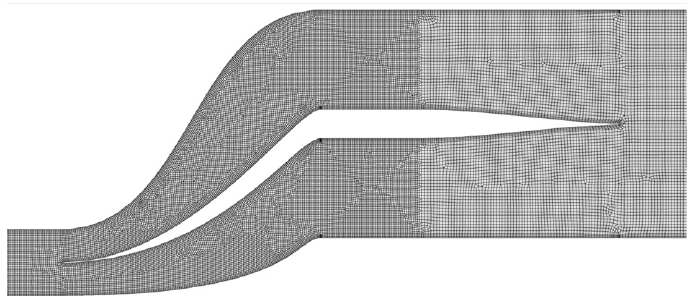
Figure 11. Example of Model 2 meshing.